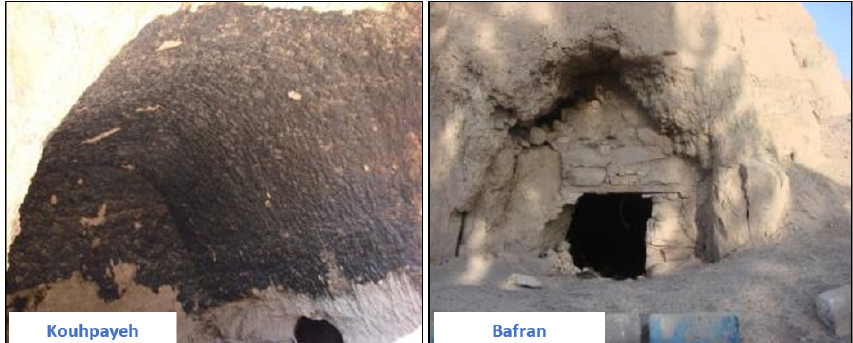
Figure 9. Arched excavation in the form of barrel arch in Koupayeh of Kerman and Bafran of Naein.